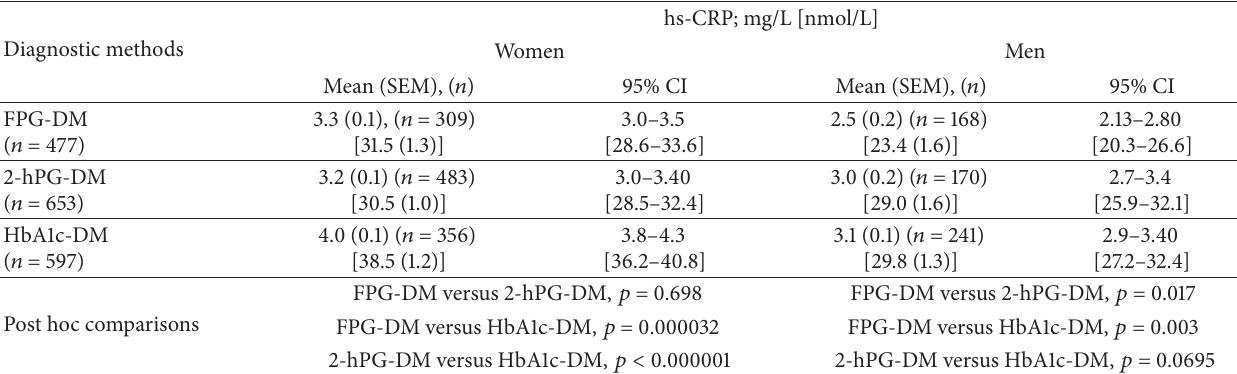
Table 3: hs-CRP levels in women and men with newly detected DM using the FPG, 2-hPG, or HbA1c criteria ∗ . Diagnostic